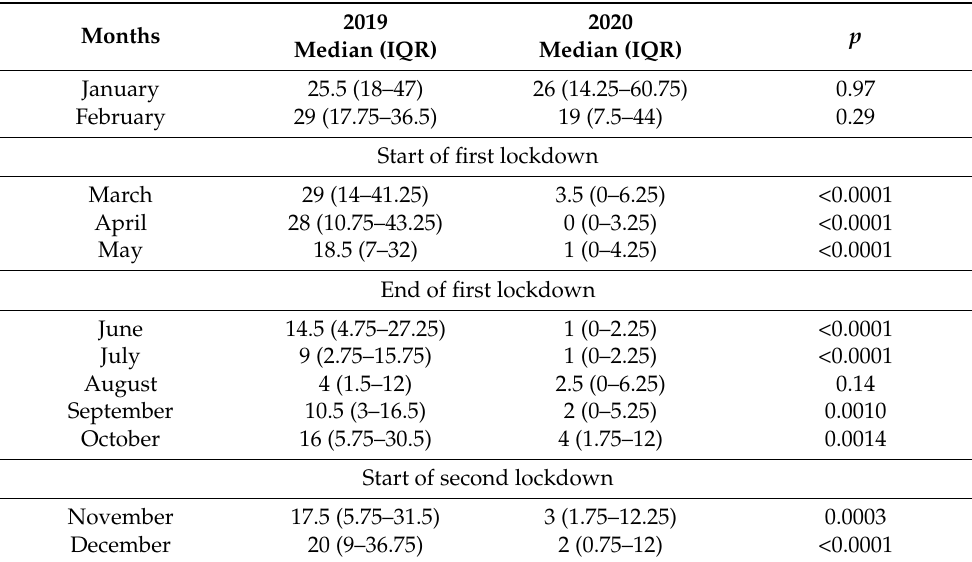
Table 6. Number of patients with pharyngitis recorded monthly in 2019 compared to 2020, in the study population of 35,787 children aged 0–14